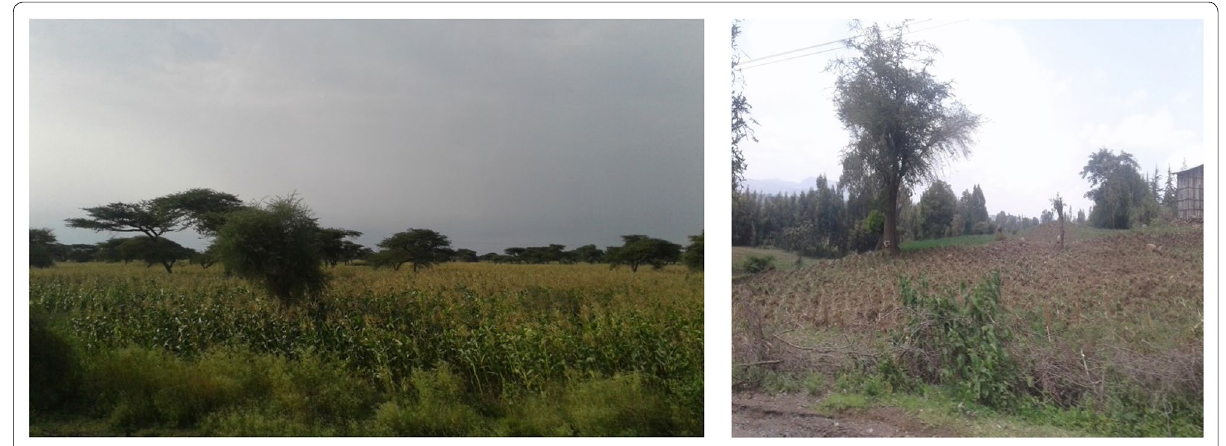
Fig. 5 Land cover in the lower zone of Meki river